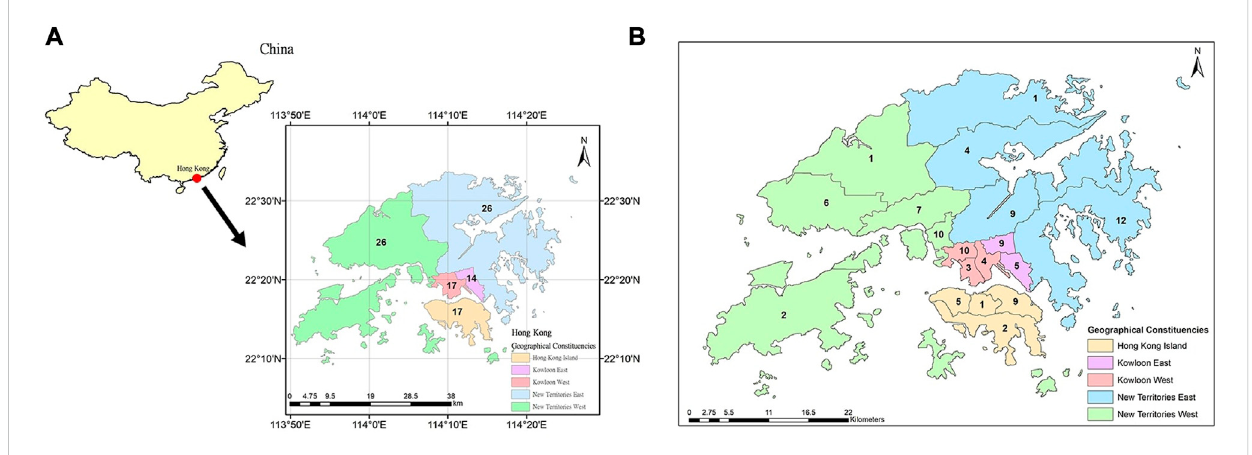
FIGURE 1 The samples of questionnaire collected from (A) fi ve geographical constituencies in Hong Kong and (B) 18 districts in Hong